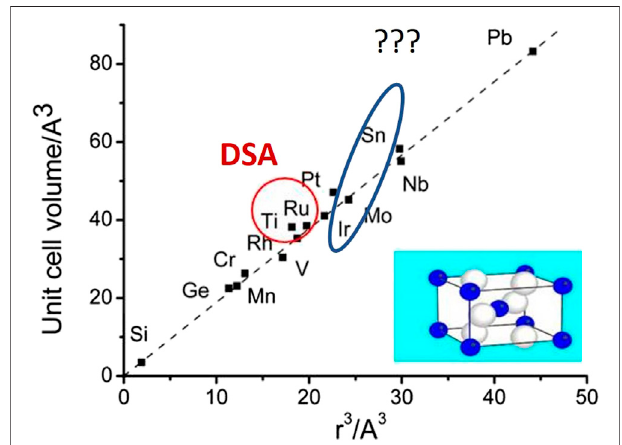
FIGURE 4 | Unit cell volume as a function of effective ionic volume for several metal oxides with rutile structure, with indicated two distinct examples of mixed oxides intensively studied in literature (i.e. TiRu mixed oxide used as commercial dimensionally stable anode (DSA) and unstable SnIr mixed oxide). Replotted using data from Shannon